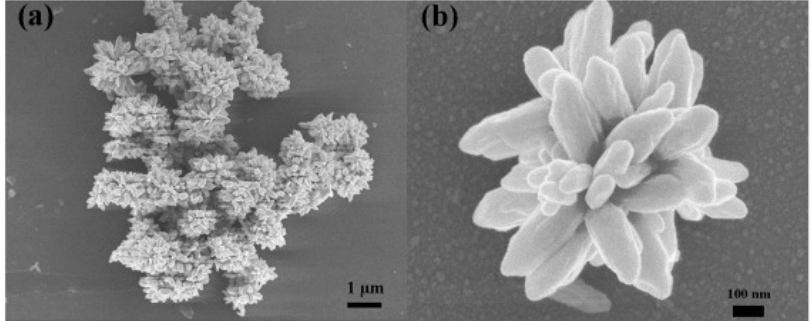
Figure 7. SEM images of ZnO nanoflowers with the resolution of ( a ) 1 μ m and ( b ) 100 nm [52].